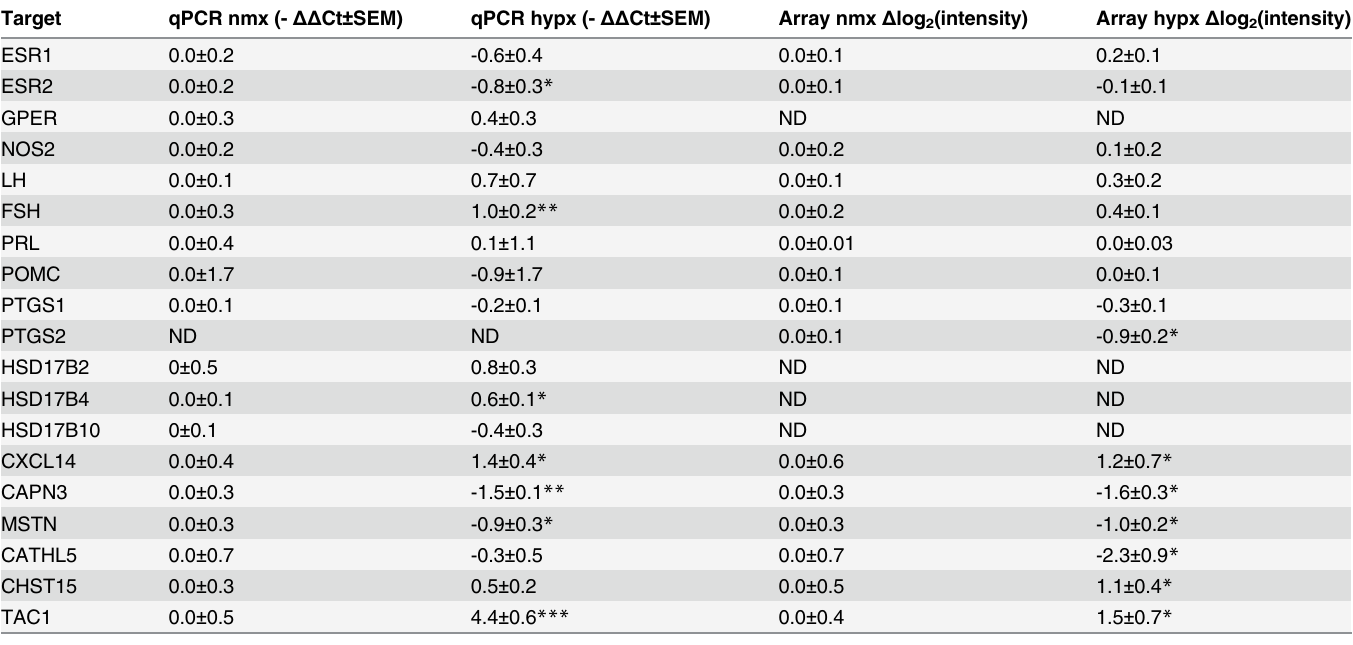
Table 6. qPCR estimates (dCt ± SEM) of mRNA abundance of genes of interest and comparison to expression on